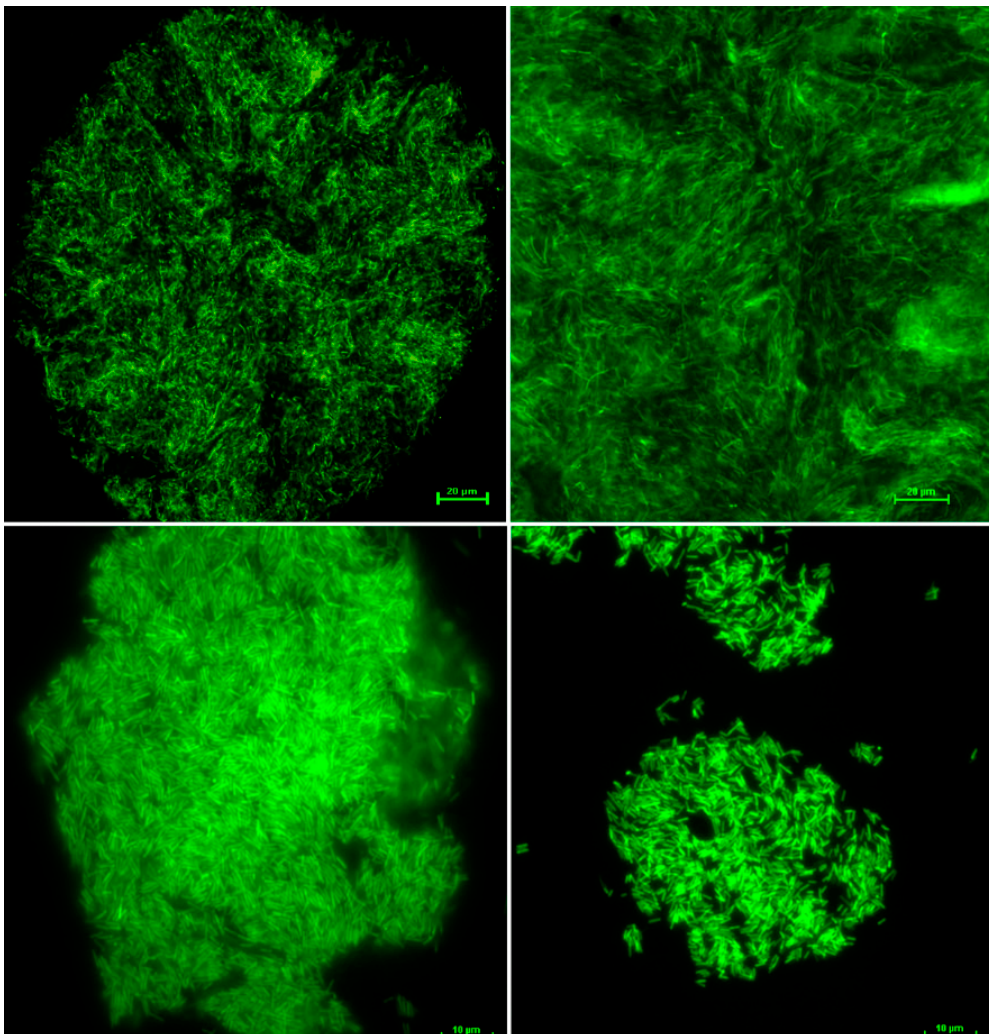
Figure 5. Fluorescence microscopy observations of X. fastidiosa strain De Donno transformed with the pKLN59 plasmid harboring the green fluorescent protein (GFP) gene. Cell aggregates were collected from buffered charcoal yeast extract (BCYE) agar plates supplemented with kanamycin, after five rounds of restreaking.